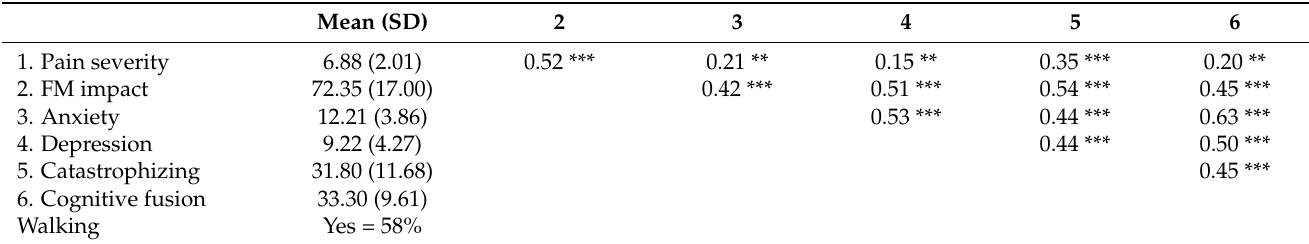
Table 1. Means, standard deviations, and Pearson correlations between study